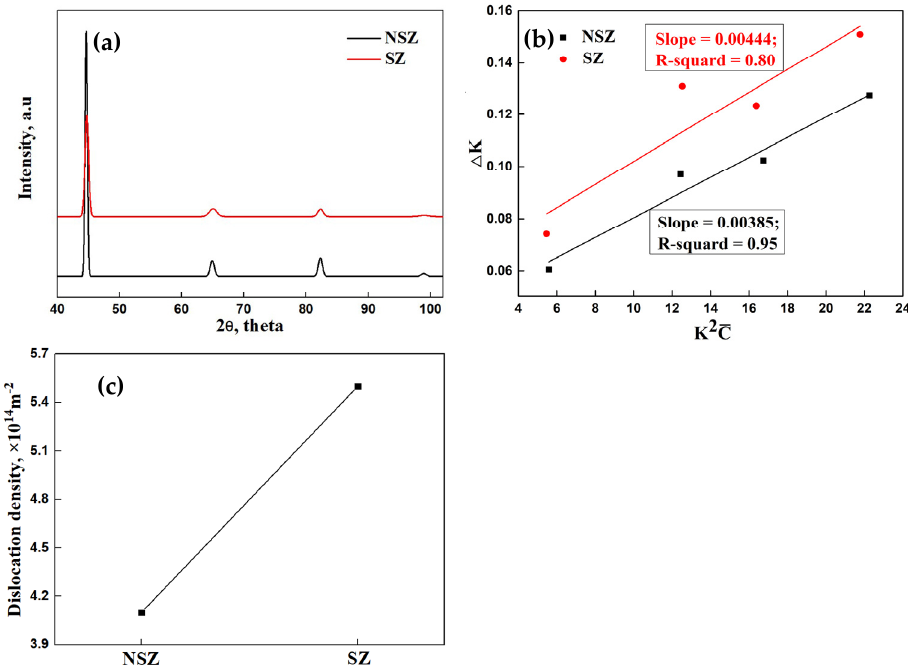
Figure 9. ( a ) X-ray diffraction profiles of the non-segregation zone (NSZ) and the segregation zone (SZ), ( b ) the fitted lines of ∆ K vs. K 2 𝐶̅ based on the modified Williamson–Hall method and ( c ) the calculated dislocation density of the NSZ and SZ.